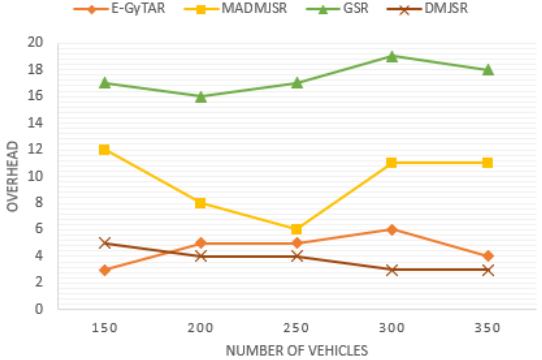
Figure 7. Routing overhead in an increasing number of